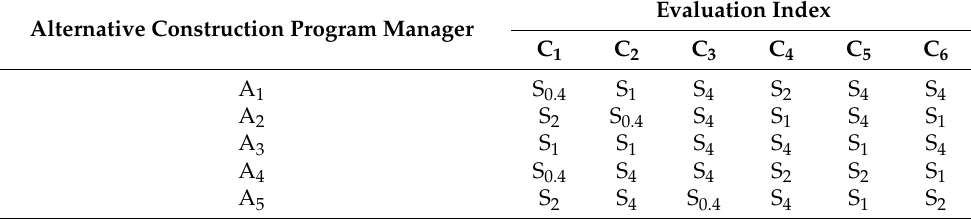
Table 5. Linguistic Multi-attribute Evaluation Matrix X 3 of decision maker D 3 .